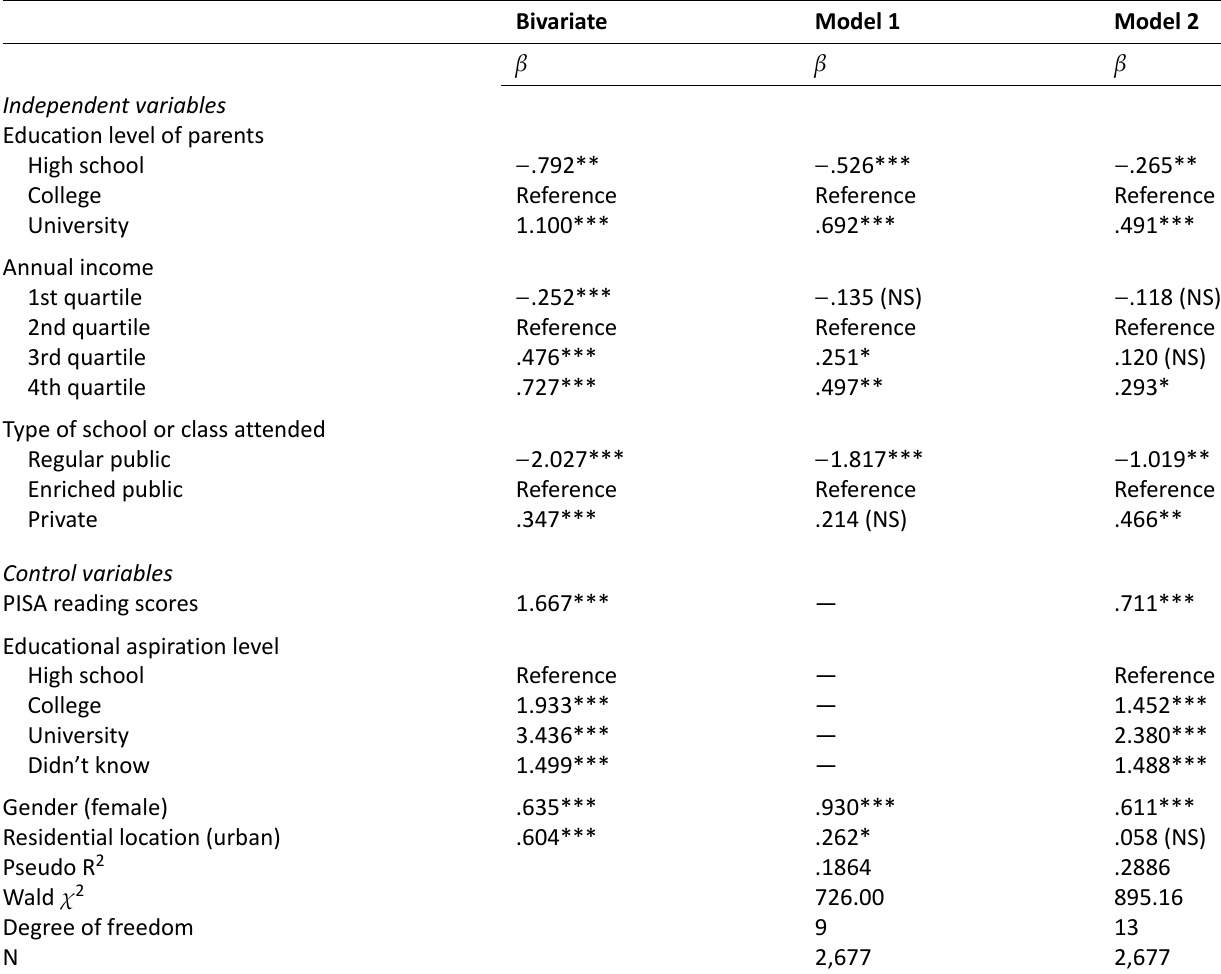
Table 3. Ordinal logistic regression